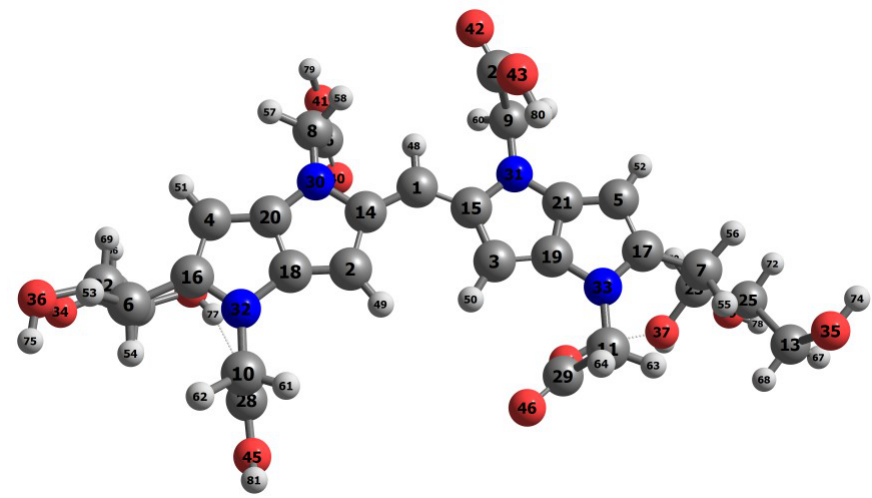
Figure 2. An schematic representation of the optimized structure of the Blue-G1 pigment calculated with the MN12SX density functional showing the numbering of the atoms.